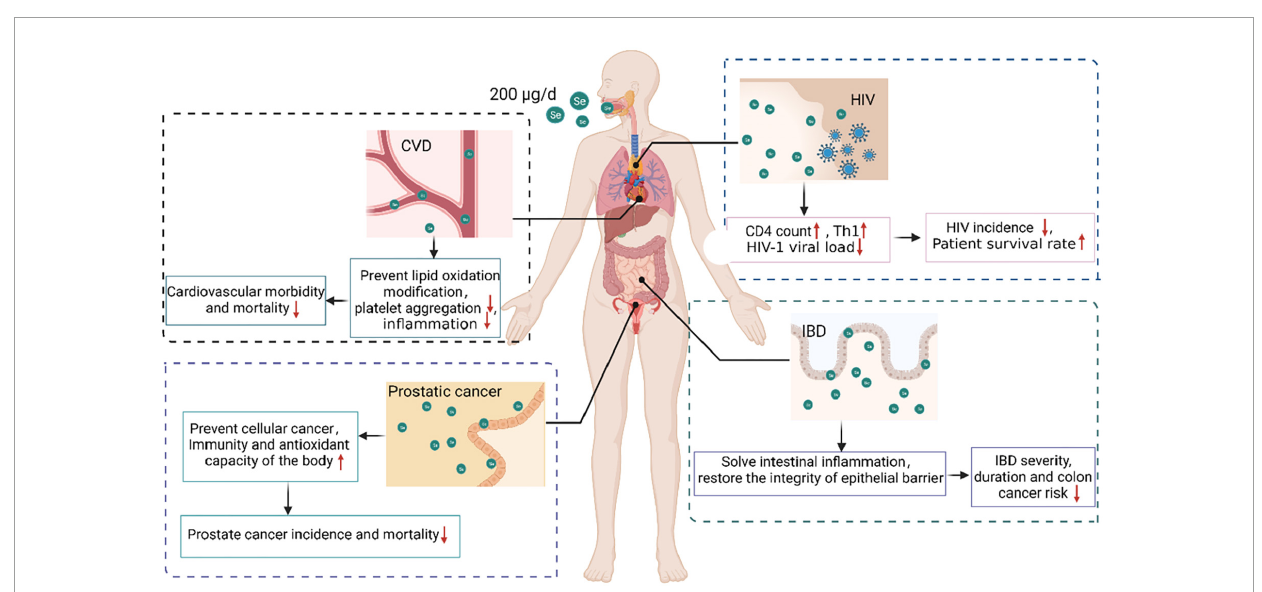
FIGURE3 Beneficial effects and mechanisms of selenium supplementation in various diseases. Selenium supplementation can provide protection for populations with AIDS, cancer, CVD, and IBD. Supplementing HIV-infected people with 200 µ g selenium per day enhanced the CD4 count, stimulated CD4 + T cell differentiation into T helper 1 cells, and decreased the HIV-1 viral load, thus decreasing HIV incidence and enhancing patient survival. Supplementing prostate cancer patients with 200 µ g of selenium per day prevented cell carcinogenesis, enhanced the body’s immunity